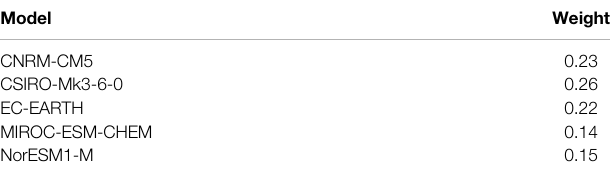
TABLE 1 | BMA weights of each model for the whole basin.